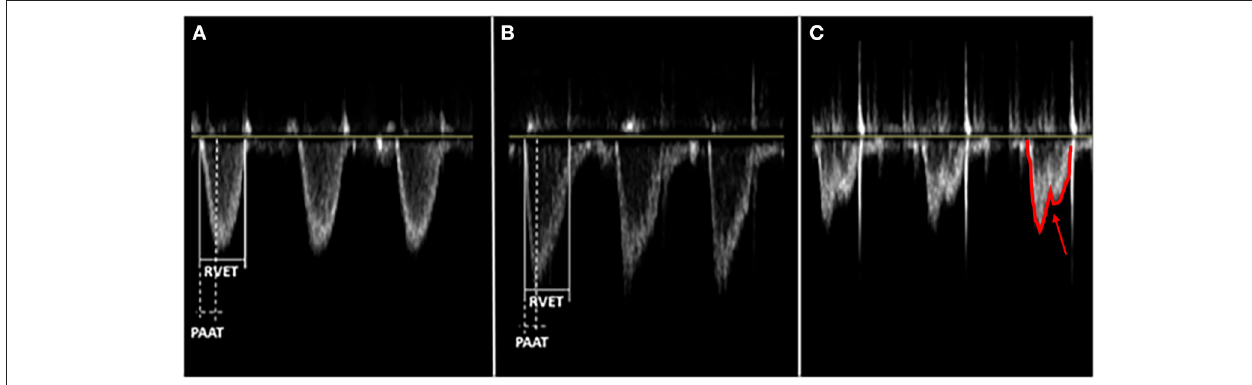
FIGURE 3 | Different main pulmonary artery (MPA) flow velocity profile patterns depend on the pulmonary vascular resistance (PVR). PVR is an index ratio of right ventricular ejection time (RVET) and pulmonary artery acceleration time (PAAT), both obtained from the right outflow tract’s pulse-wave doppler. PAAT, as shown, is the interval from the onset of ejection through the pulmonic valve to the peak flow velocity. These are three distinct patterns of flow velocity envelope: (A) Parabolic or normal PVR - Isosceles triangle, RVET:PAAT < 4; (B) Right-angle triangle or increased PVR - RVET:PAAT > 4; (C) Notched pulmonary artery doppler or severe increase in PVR - two distinct peaks (arrow) from midsystolic flow